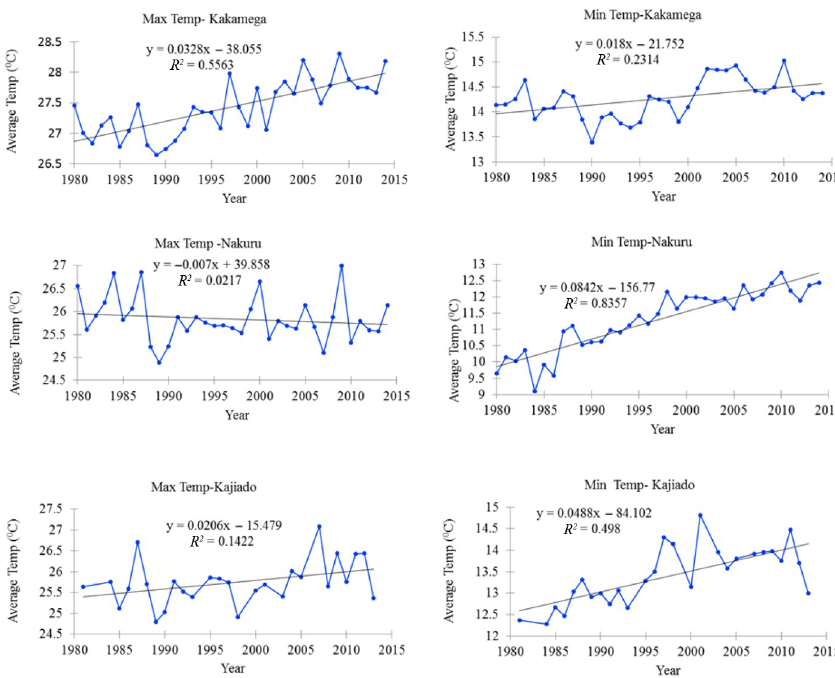
Figure 4. Mann–Kendall graphs for annual maximum and minimum mean